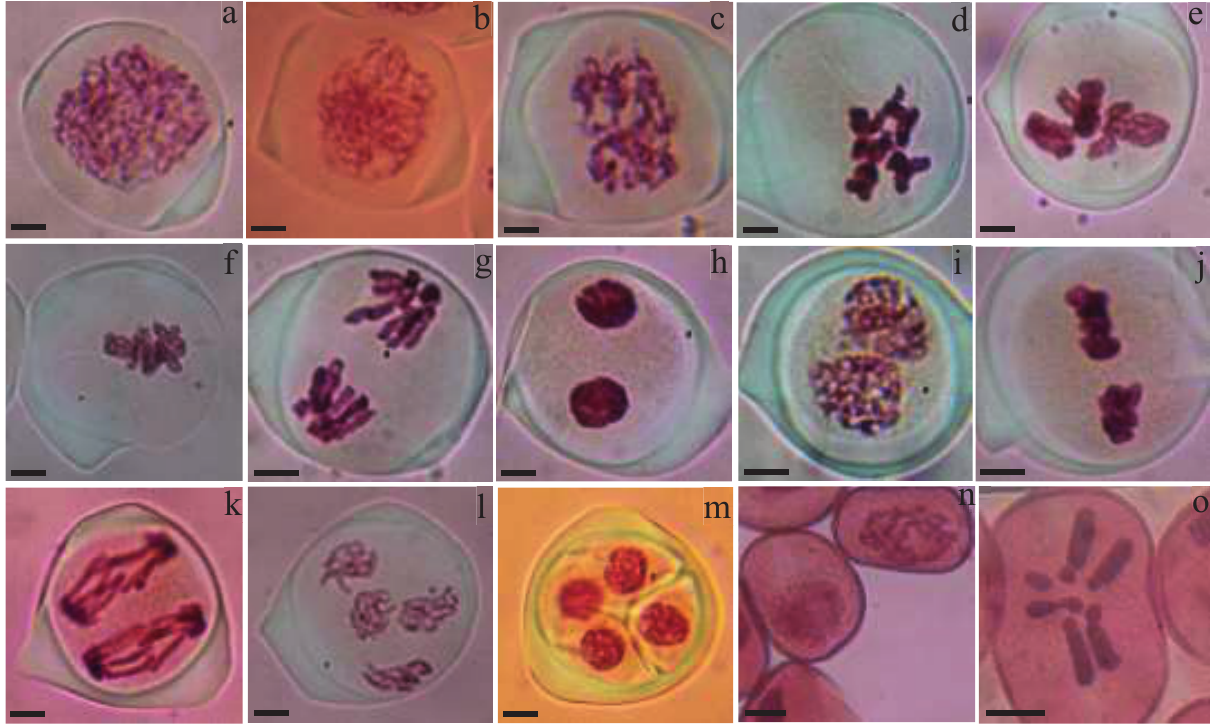
Figure 3. Microsporogenesis and microspore mitosis of the experimental hybrid Aloe jucunda x A. vera . a) Prophase-I (Leptotene), b) Pro- phase-I (zygotene), c) Prophase-I (pachytene), d) Prophase-I (diplotene), e) Prophase-I (diakinesis), f) Metaphase-I , g) anaphase-I, h) tel- ophase-I, i) prophase-II, j) metaphase-II, k) anaphase-II, l) telophase- II, m) tetrad, n) microspores initiating fi rst mitosis, o) microspore in metaphase showing haploid chromosomes (n=x=7=4L+3S). Scale bars = 10